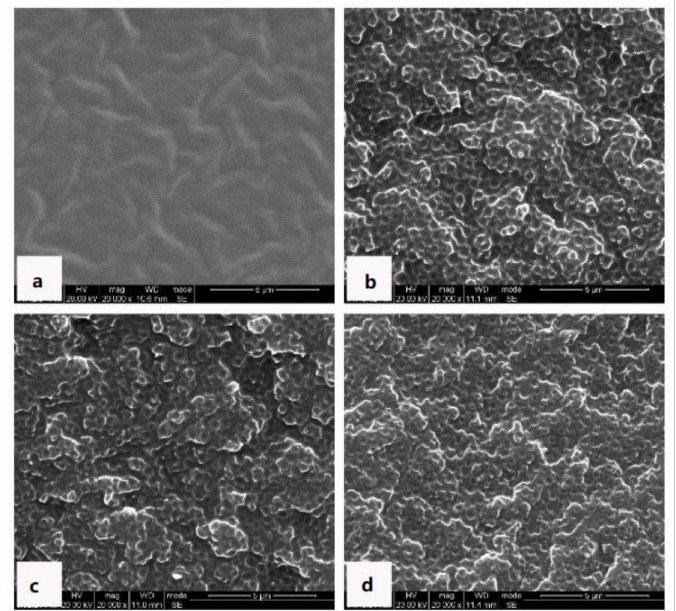
Figure 7. Morphological evolution process of MOEA-BOZ/DGEBA-ER/IMZ (12 wt%) blend with 50 wt% of ER after curing at different stages: ( a ) 110 ◦ C/5 min; ( b ) 110 ◦ C/40 min; ( c ) 110 ◦ C/9 h; ( d ) 110 ◦ C/24 h + 130 ◦ C/2 h.